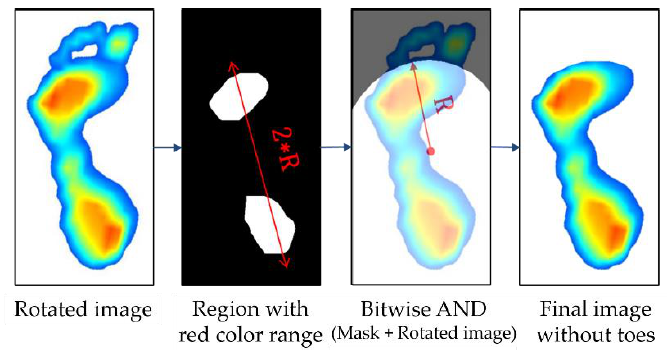
Figure 7. Steps in generating toe-less image.